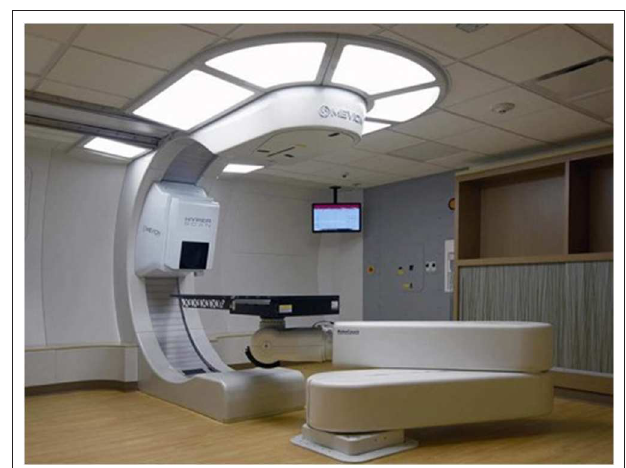
FIGURE 1 | Mevion S250i Proton Therapy System with Hyperscan Pencil Beam Scanning and Adaptive Aperture installed at the MedStar Georgetown University Hospital Proton